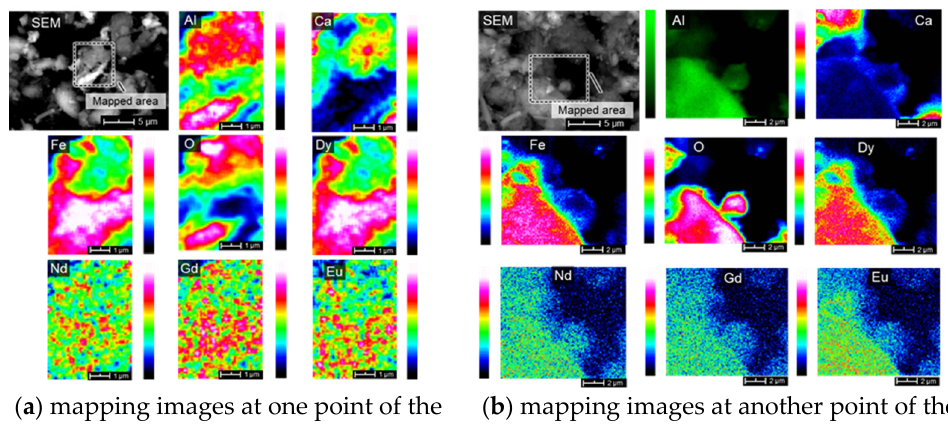
Figure 4. SEM-EDS images at ×5000 magnification with elemental map at different locations of the CFA sample.